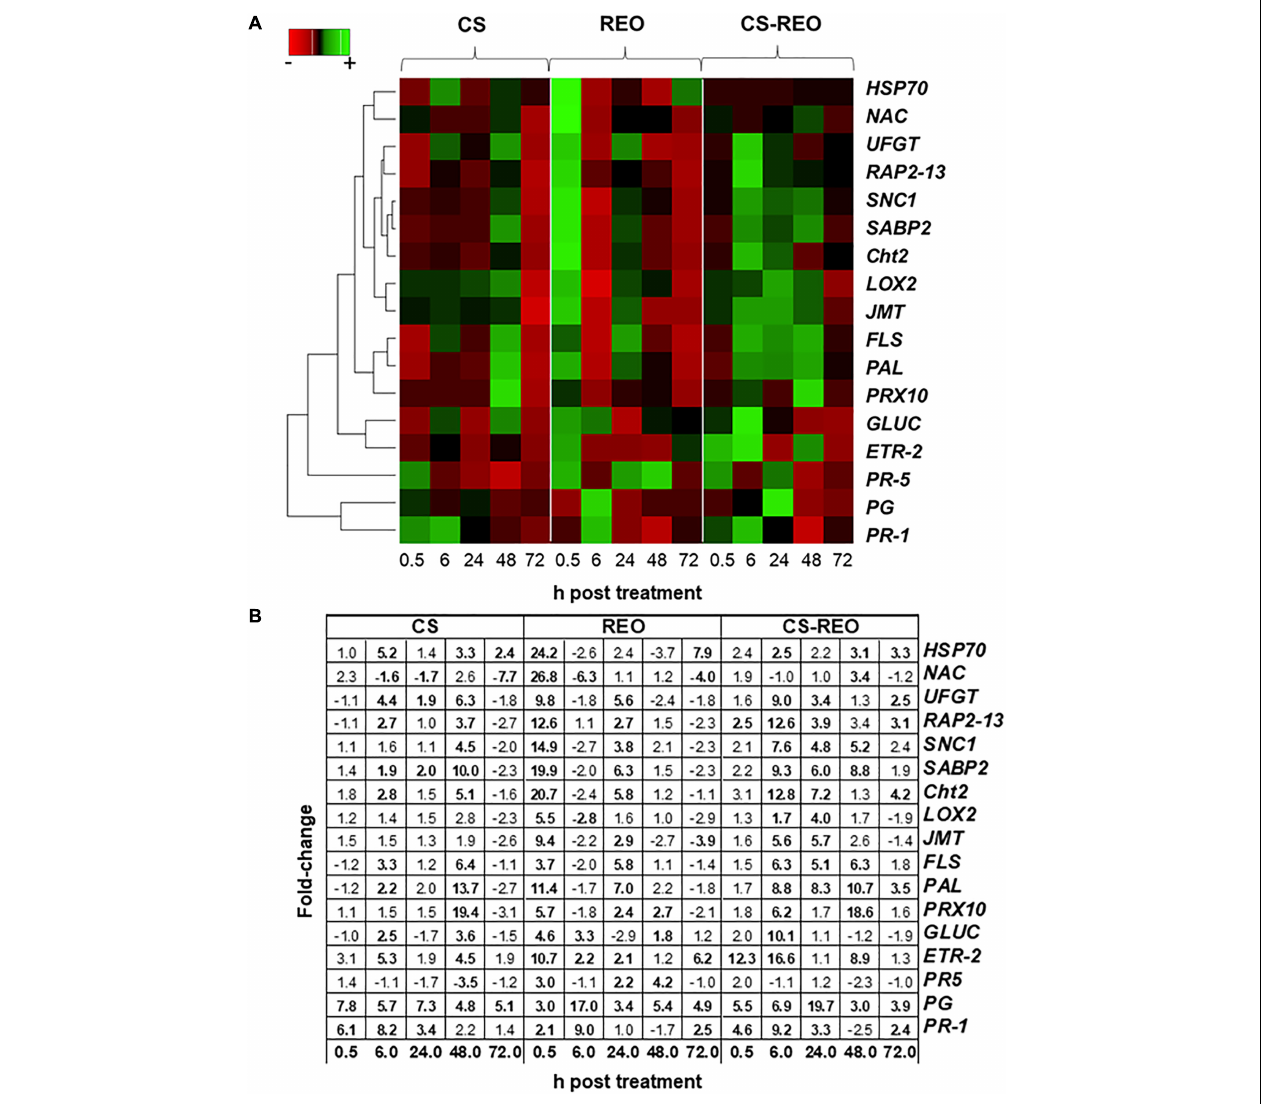
FIGURE 3 | Gene expression heatmap. Hierarchical clustering according to Pearson’s correlation similarities and average linkage of the defense genes examined (as indicated; refer to Table 1 ) in papaya fruit following treatments with 0.5% CS, 0.5% REO, and their combination (CS-REO). For each gene, the maximum (green color) and minimum (red color) fold-changes are compared to the control (water) treatment at 0.5, 6, 24, 48, and 72 h posttreatment (A) . The average fold-change values compared to the control (water) treatment at 0.5, 6, 24, 48, and 72 h posttreatment, used for hierarchical clustering, were shown. In bold, the data significantly different ( P ≤ 0.05; Duncan’s multiple range tests), compared to relevant controls were indicated (B)